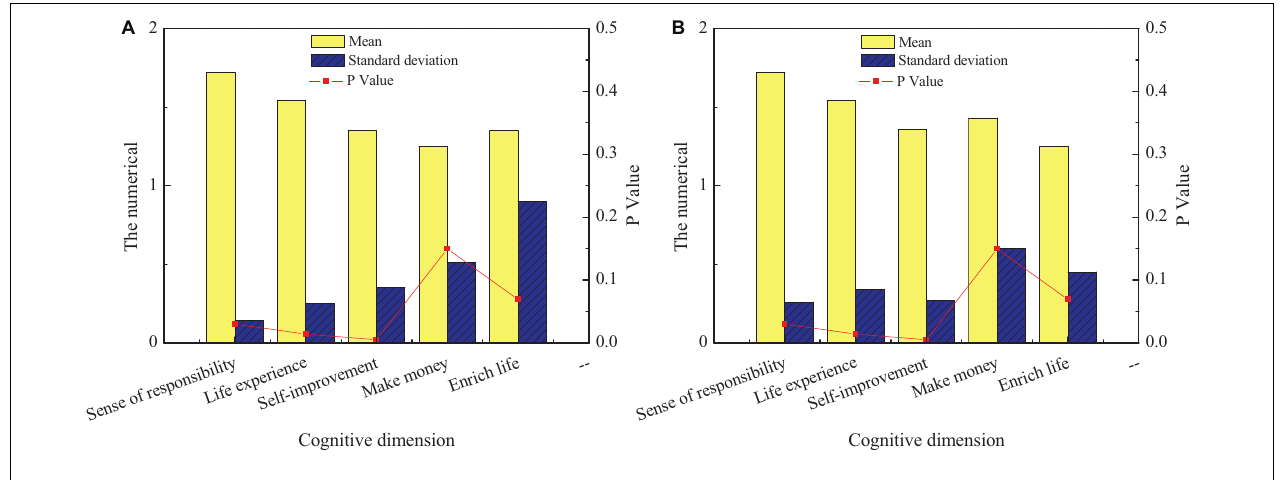
FIGURE 9 | Comparison of entrepreneurial emotion among students of different disciplines: (A) liberal arts and (B) science.